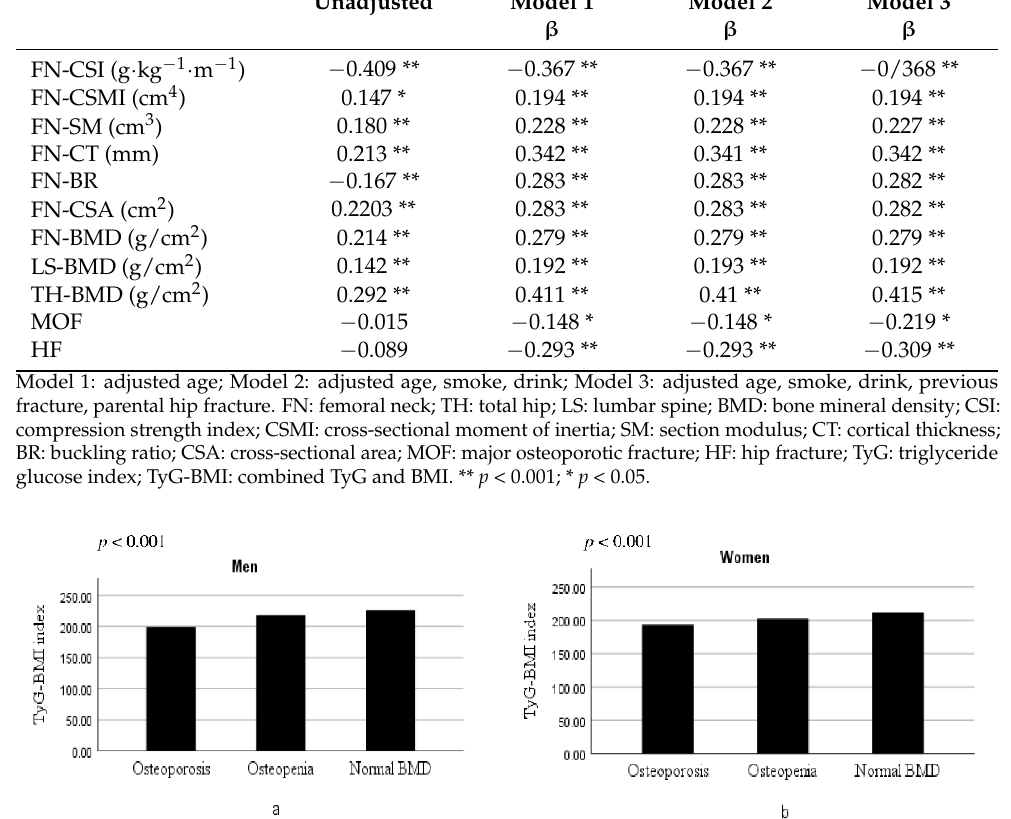
Table 5. Multivariable logistic regression analyses between possible predictors and osteoporosis. Adjusted with age, sex, 25(OH)D, current smoker, current drinker. Unadjusted OR (95% CI)